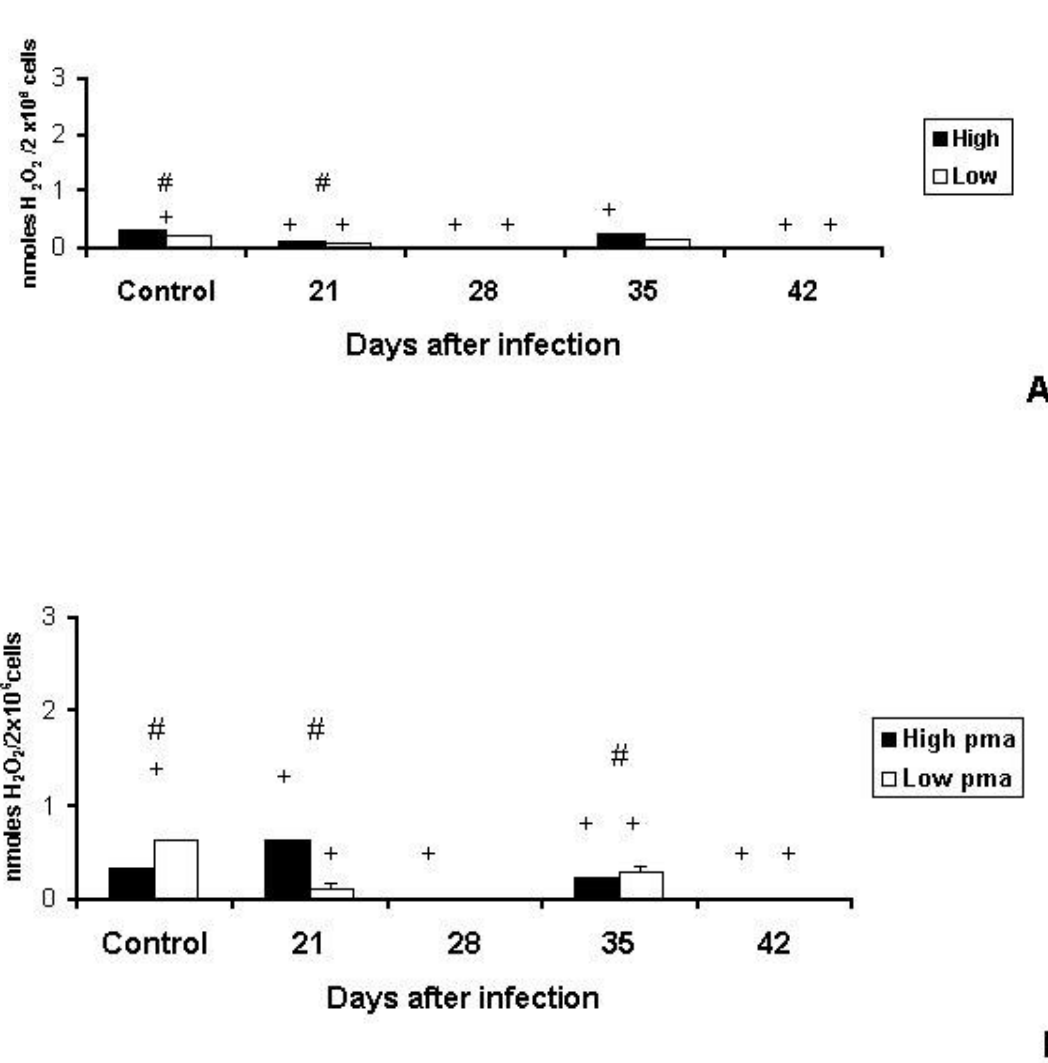
O (nmoles H O /2X10 6 cells) by pulmonary macrophages 2 2 2 2 at different periods, compared with their respective 5 O by macrophages of infected High and 2 2 O by macrophages of infected High and 2 2